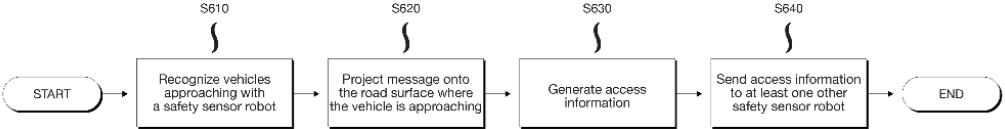
Figure 9. Vehicle induction: information generation from the robot device via access point function.